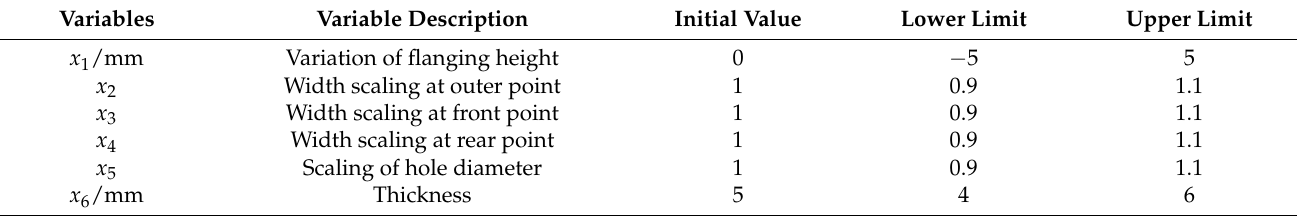
Figure 10. Parameterized model of the control arm and its design variables. Table 3. Design variables and value range of control arm.